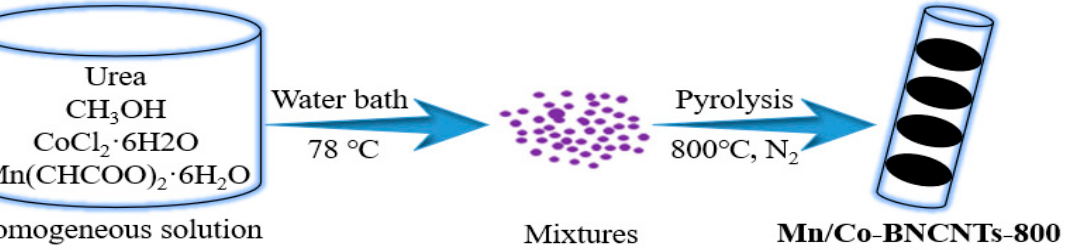
Figure 12. The synthesis method of Mn/Co-BNCTs catalyst. Adapted with permission from Ref. [134]. Copyright 2019 Elsevier.